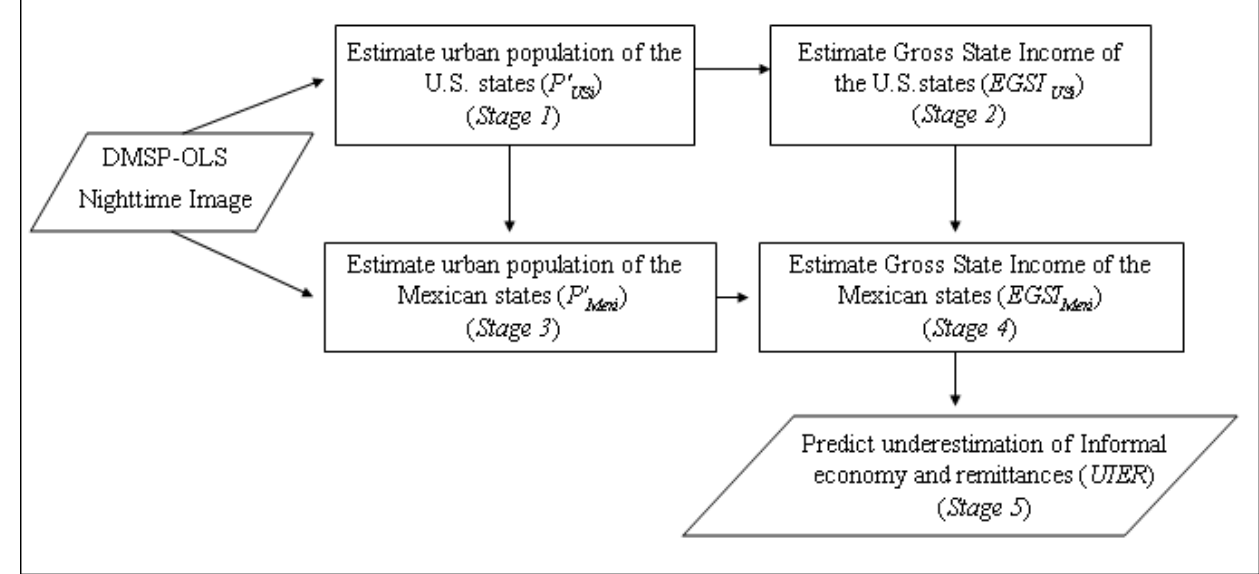
Figure 3. Overview of the model to predict the underestimation of informal economy and remittances in Mexico’s official GNI measure